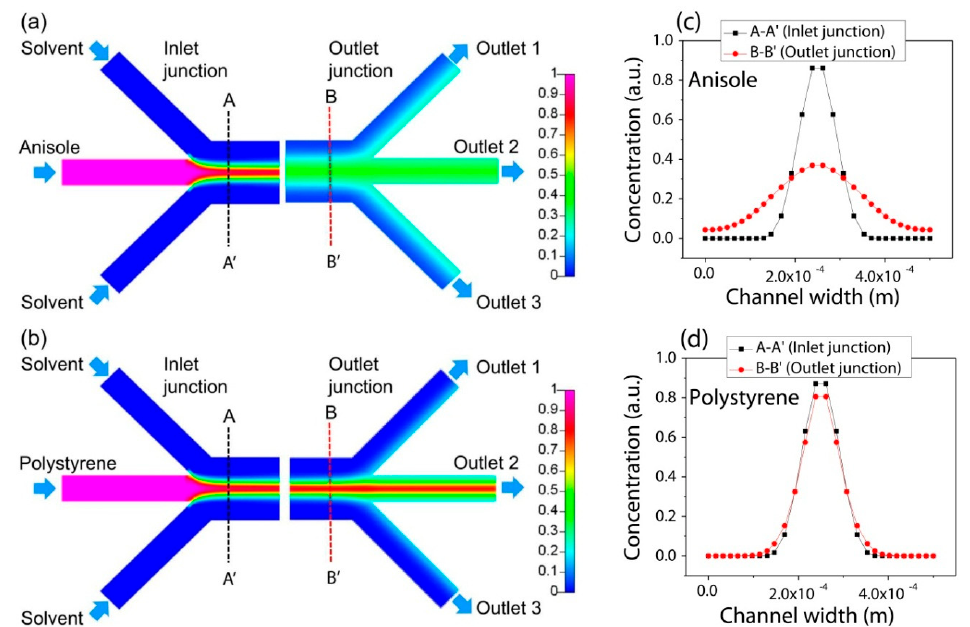
Figure 2. Numerical analysis of the concentration change along the channel length for an inlet flow rate of 500 µL/min of the mixture and 1500 µL/min of the solvent: ( a ) anisole; ( b ) polystyrene (PS); ( c ) concentration profile of anisole; ( d ) concentration profile of PS.